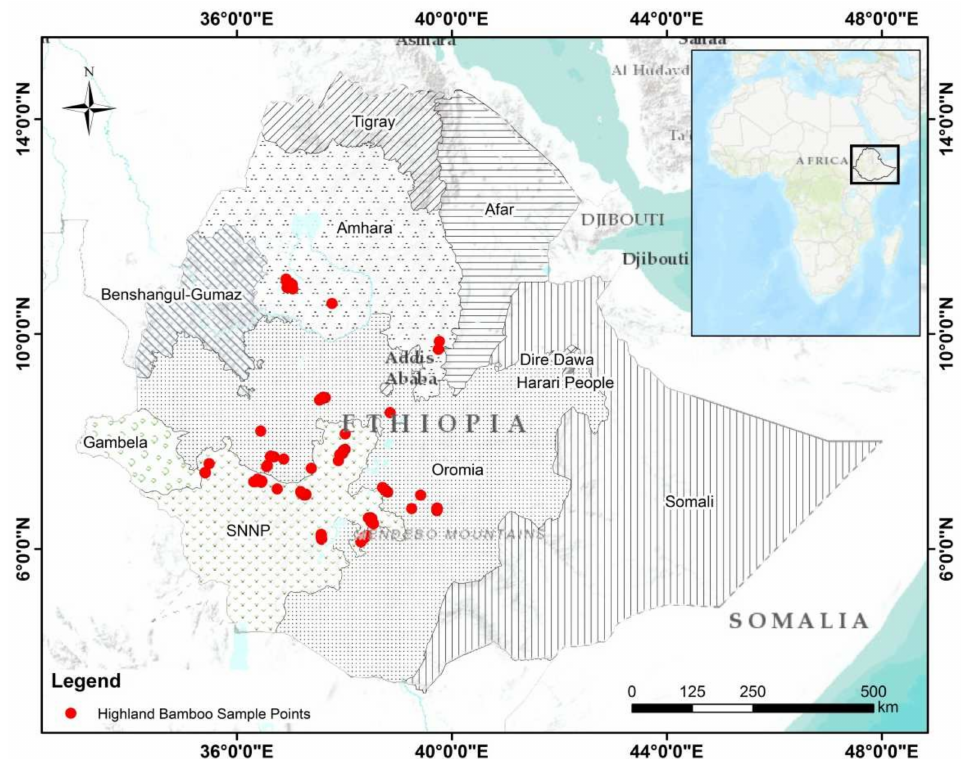
Figure 1. Highland bamboo occurrence data collection